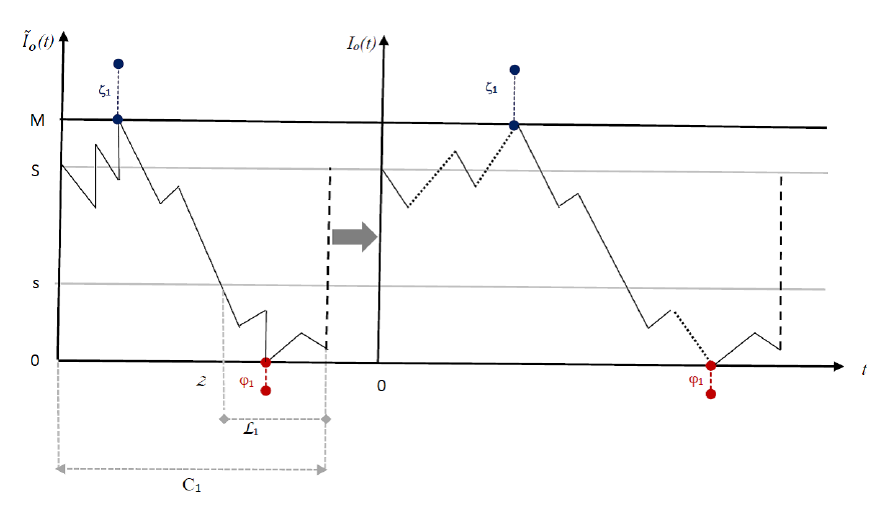
Figure 3. The MMFF process I o for (cid:101) I o